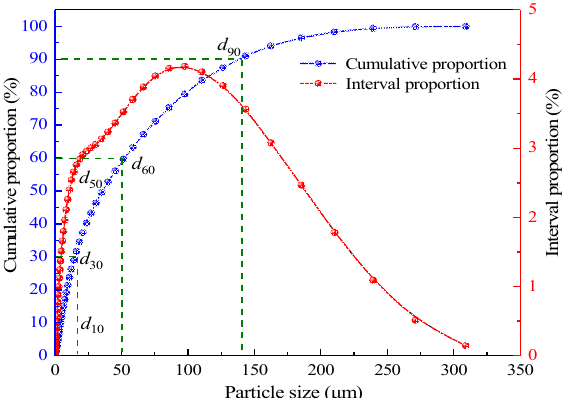
Figure 3. Fly ash particle size distribution curve.